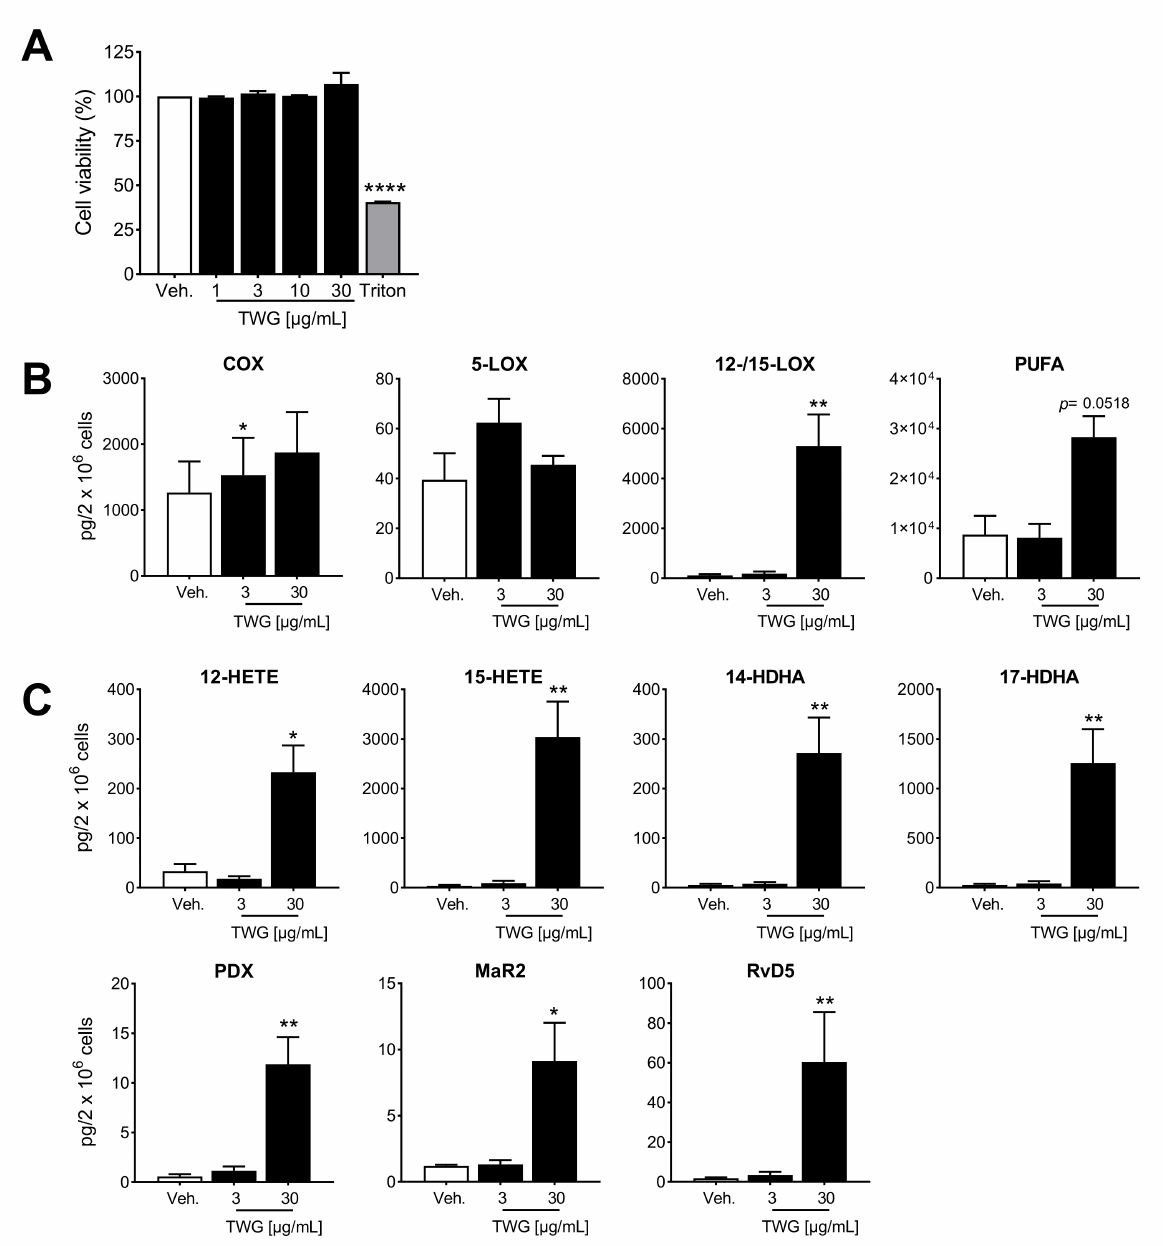
Figure 3. TWG induces LM production in anti-inflammatory human M2-MDM. ( A ) M2-MDM were treated with TWG at the indicated concentrations, 1% triton X-100, or 0.1% DMSO as vehicle for 3 h. Then, cell viability was assessed by MTT assay. Values are means + S.E.M., n = 3, expressed as percentage of vehicle control (=100%); **** p < 0.0001, TWG vs. control group, one-way ANOVA for multiple comparisons with Bonferroni’s correction. ( B , C ) M2-MDM were treated with 3 or 30 µ g/mL TWG or with 0.1% DMSO as vehicle for 180 min and LM from cells supernatants were analyzed by UPLC-MS/MS. ( B ) The sum of COX products, 5-LOX products, 12/15-LOX products and PUFA are expressed as pg/2 × 10 6 cells of TWG-treated and vehicle-treated cells. ( C ) Individual members of 12/15-LOX products, expressed as pg/2 × 10 6 cells of TWG-treated and vehicle-treated cells. Data are means + S.E.M., n = 5 and were log-transformed for statistical analysis, * p < 0.05, ** p < 0.01, TWG vs. control group, one-way ANOVA and Dunnett’s multiple comparisons